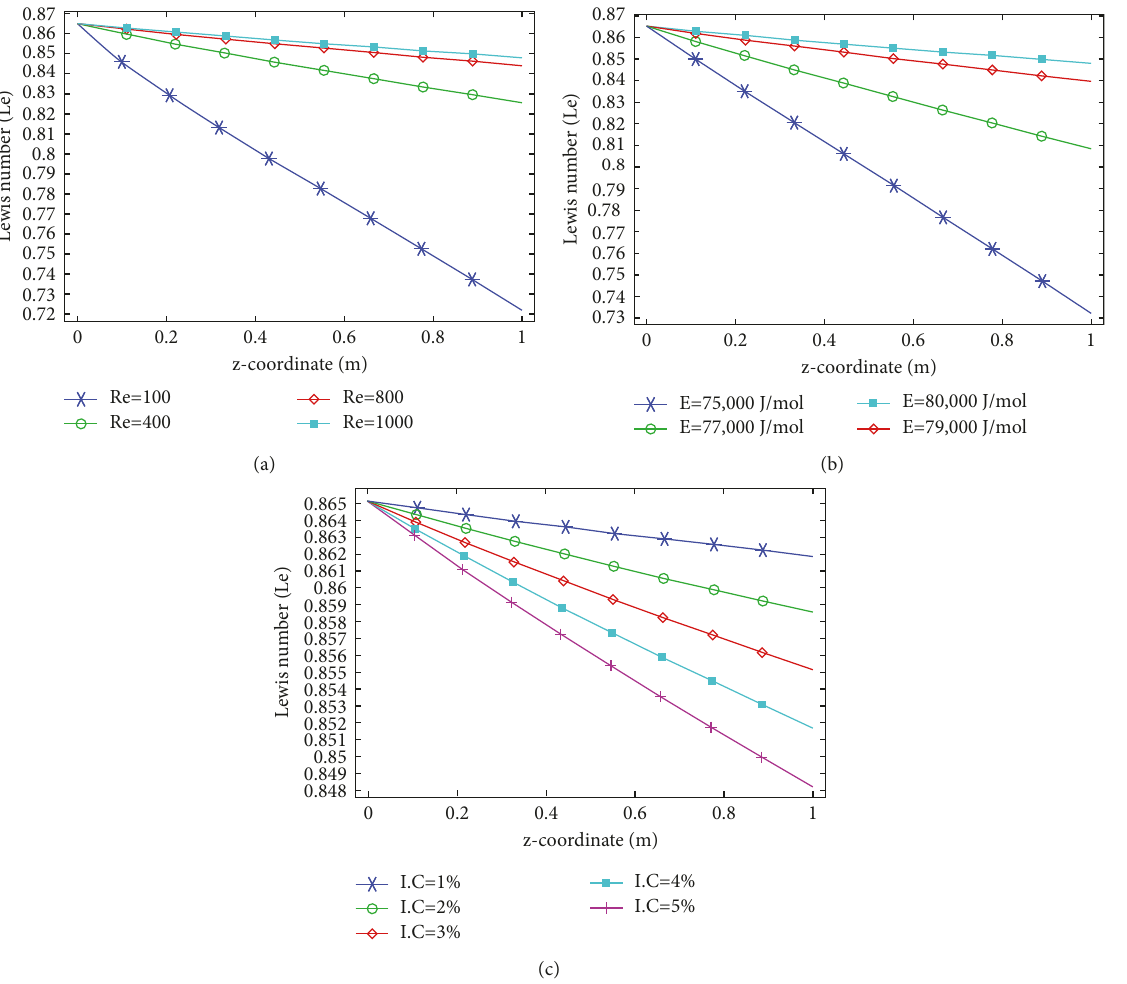
Figure 17: Lewis number along the length of the channel: (a) I.C � 5%, E � 80,000J/mol; (b) I.C � 5%, Re � 1000; (c) Re � 1000, E � 80,000J/